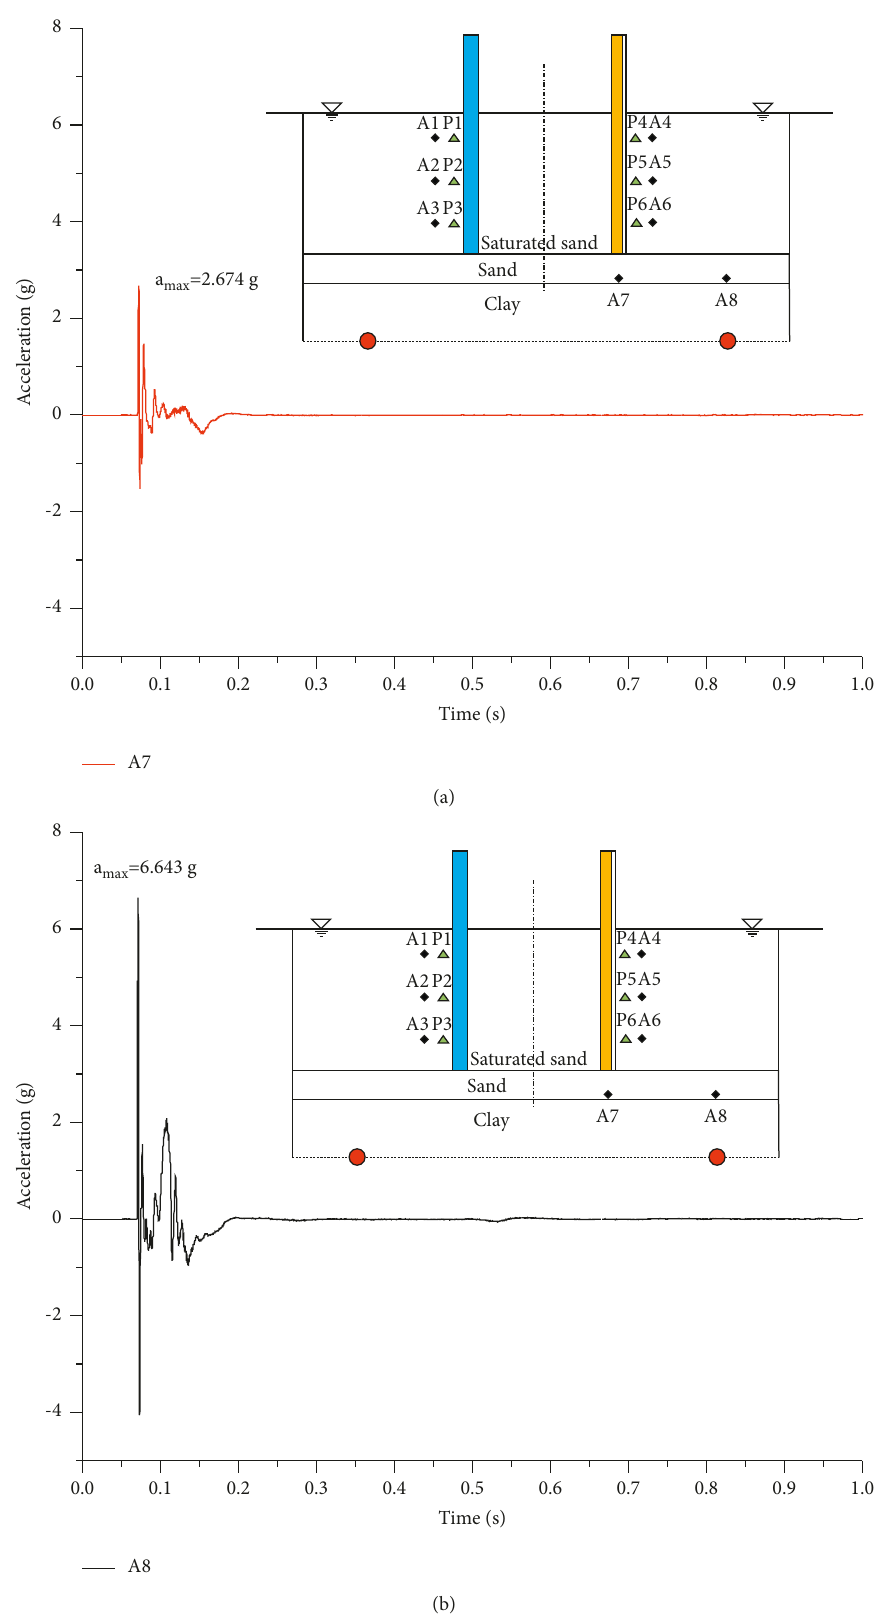
Figure 12: Vertical acceleration response of pit bottom after simultaneous fracturing blast vibration test. (a) Vertical acceleration time curve of the A7 sensor. (b) Vertical acceleration time curve of the A8